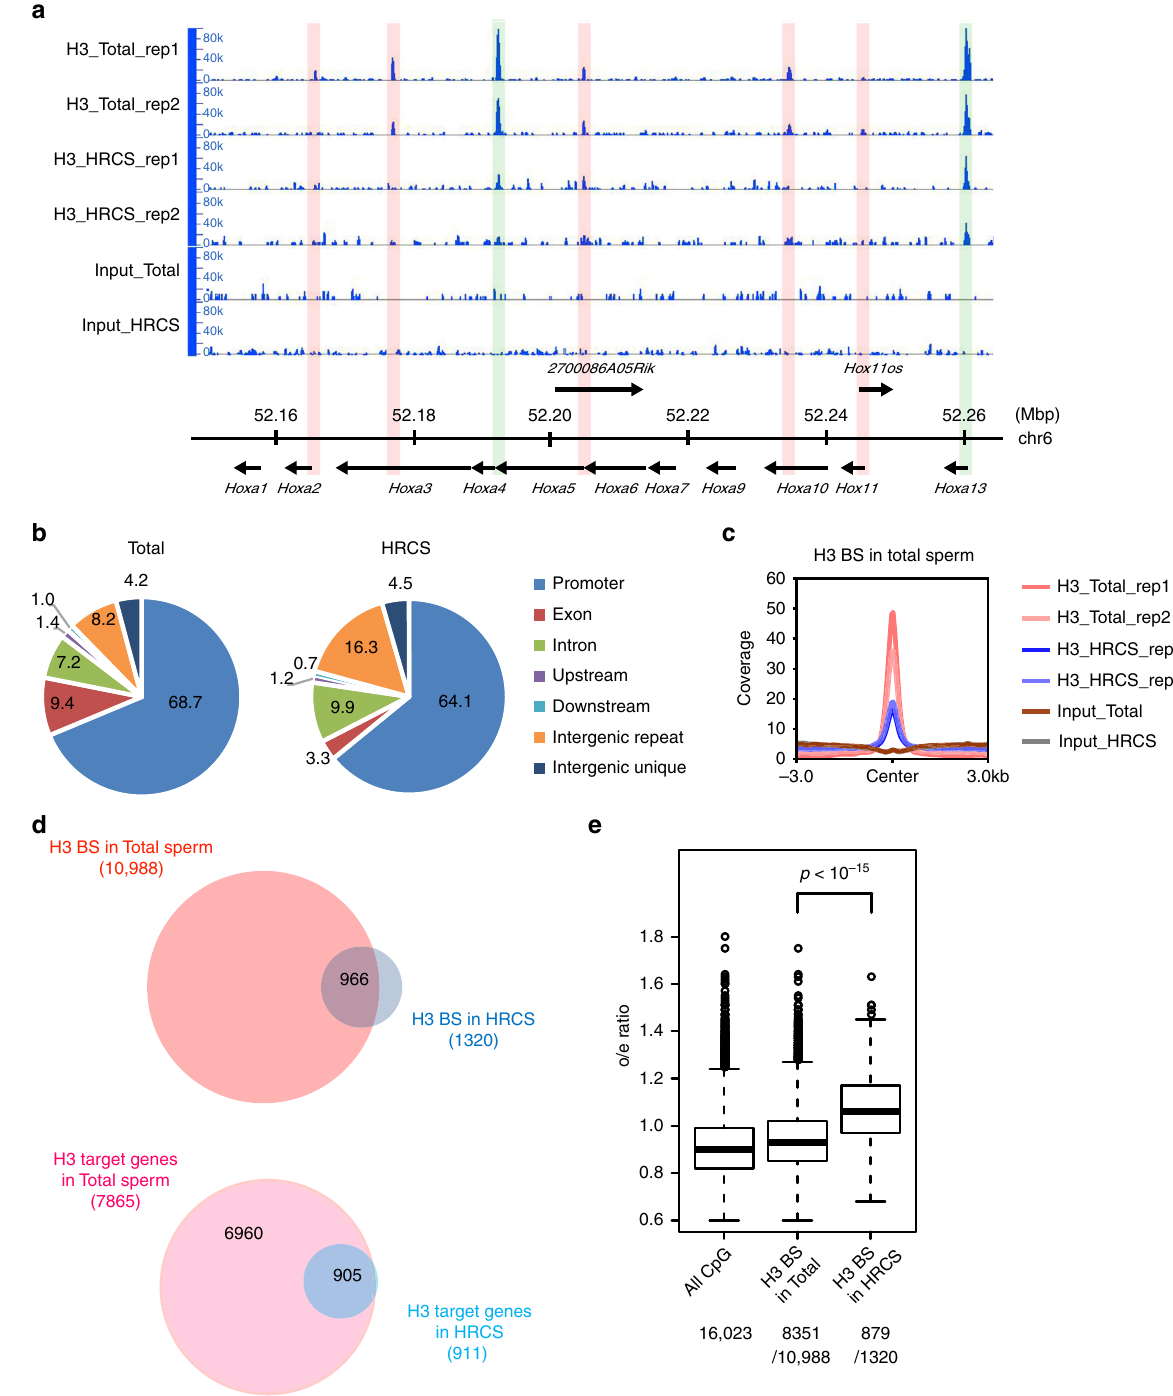
Fig. 3 Analysis for H3-binding regions in total sperm and HRCS. a H3 ChIP-seq analysis for total sperm and HRCS in Hoxa gene cluster regions. Blue signal indicates the number of raw reads, which is scaled to mapped regions in each sample. Light blue boxes indicate the binding sites detected in both total sperm and HRCS. Light red boxes indicate the binding sites detected only in total sperm. b Distribution of H3 peaks detected in total sperm and HRCS (10,988 and 1320 peaks, respectively) among various genomic regions. c Pro fi le plot for signal intensity of H3 ChIP-seq around binding sites detected in total sperm and HRCS. d Overlap of H3-binding sites (top) or H3 target genes (bottom) between total sperm and HRCS. e Box plot for o/e ratio in all CpG islands or the CpG islands overlapping with H3-binding sites in total sperm or HRCS. The number of CpG islands overlapping with H3-binding sites in total sperm or HRCS is shown at the bottom. The elements in box plot indicate following value; center line, median; box limits, upper and lower quartiles 1.5x interquartile range; and points, outliers. P value was calculated by Wilcoxon rank-sum